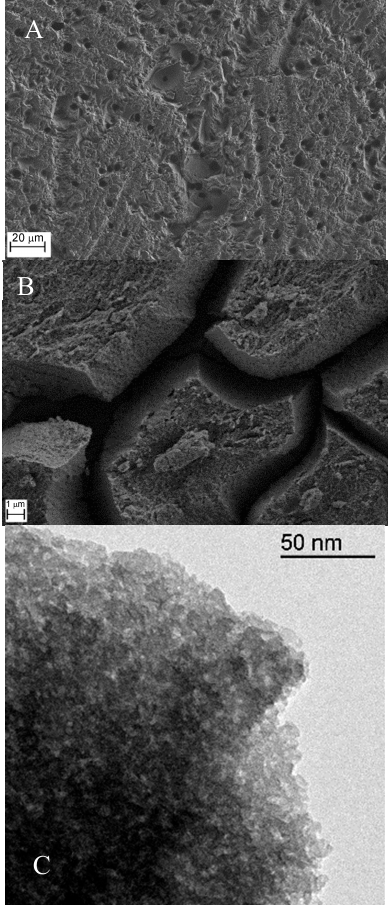
Figure 1. Micrographs obtained by FESEM for an unmodified GC electrode ( A ), a silica-modified electrode ( B ), and a TEM micrograph of the same silica deposit ( C ).